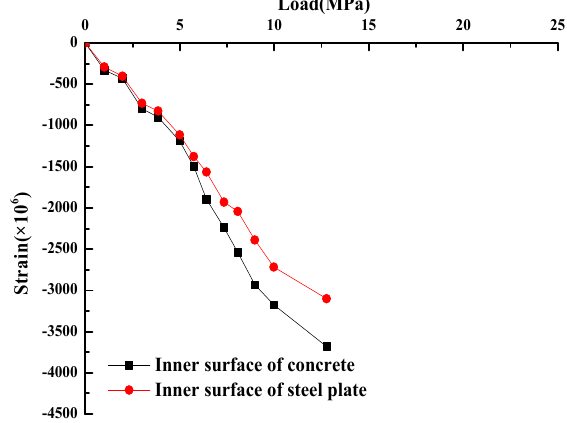
Figure 5. Load–hoop strain curves of model ZJ1. Figure 6. Load–hoop strain curves of model ZJ4.